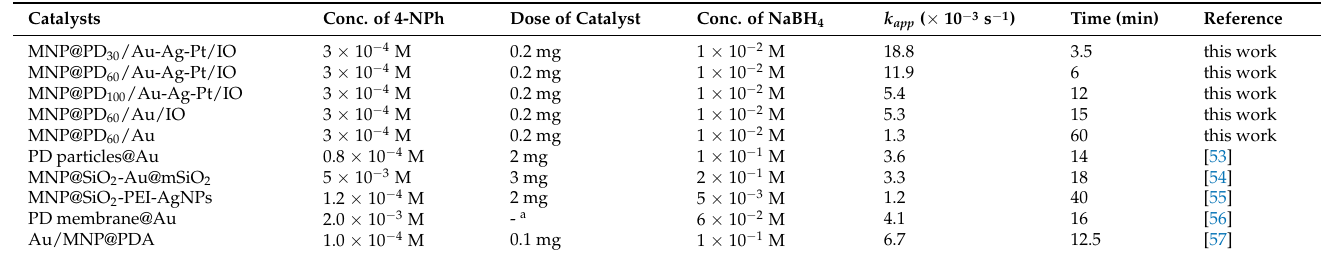
Figure 7. Plot of -ln( C t / C 0 ) versus time ( t ) for the reduction of 4-NPh with MNP@PD 30 /Au-Ag-Pt/IO. Table 1. Comparison of the catalytic activity of various metal nanocatalysts deposited on Fe 3 O 4 nanoparticles for the reduction of 4-NPh.